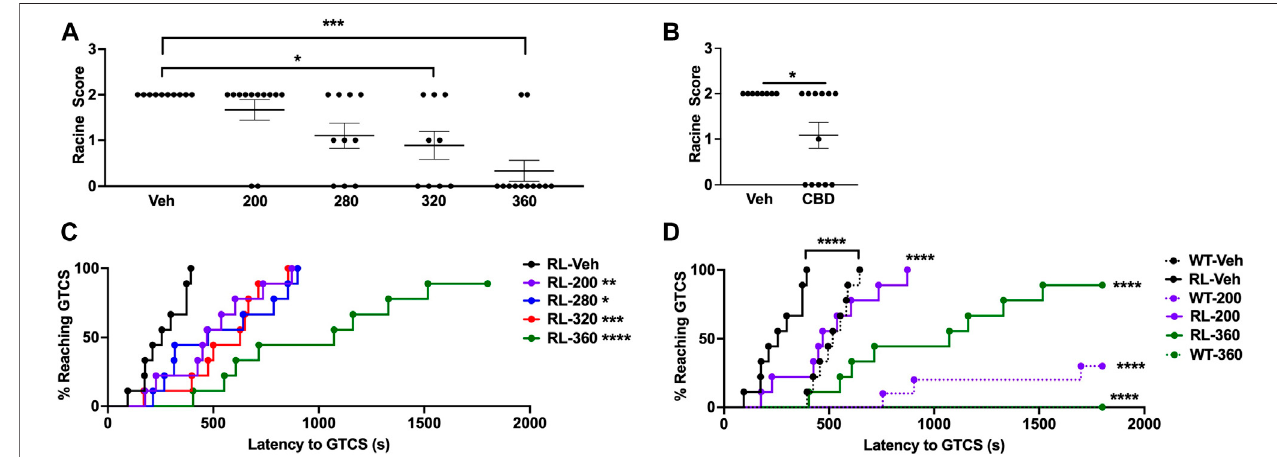
FIGURE1| CBDsigni fi cantlyincreasesresistanceagainstinducedseizures. (A) Adose-responsecurvewasgeneratedusingthe6 Hzseizureinductionparadigm. Both 320 and 360 mg/kg CBD were able to protect against 6 Hz seizures in RL/+ mutants. N (cid:1) 9 – 12/group. (B) We retested the highest dose of CBD (360 mg/kg) in a separate cohort of RL/+ mutants and found that it wasalso able tosigni fi cantly increase resistance against 6 Hz seizures at twice the convulsive current (2xCC, 32 mA). N (cid:1) 8 – 12/group. (C) We generated a dose-response curve using the PTZ seizure induction paradigm, and similarly observed a dose-dependent increase in the latency to the fi rst generalized tonic-clonic seizure (GTCS). N (cid:1) 9/group. Signi fi cance was determined when compared to vehicle-treated RL/+ mutants. (D) RL/+ mutantsandWT littermates were treatedwith CBD(200 or360 mg/kg)orvehicleand subjectedtoPTZ administration.Weobservedsigni fi cantprotection against PTZ- inducedseizureswithbothdosesofCBD. N (cid:1) 8 – 10/group.Signi fi cancewasdeterminedwhencomparedtovehicle-treatedmiceofthesamegenotype.* p ≤ 0.05,** p ≤